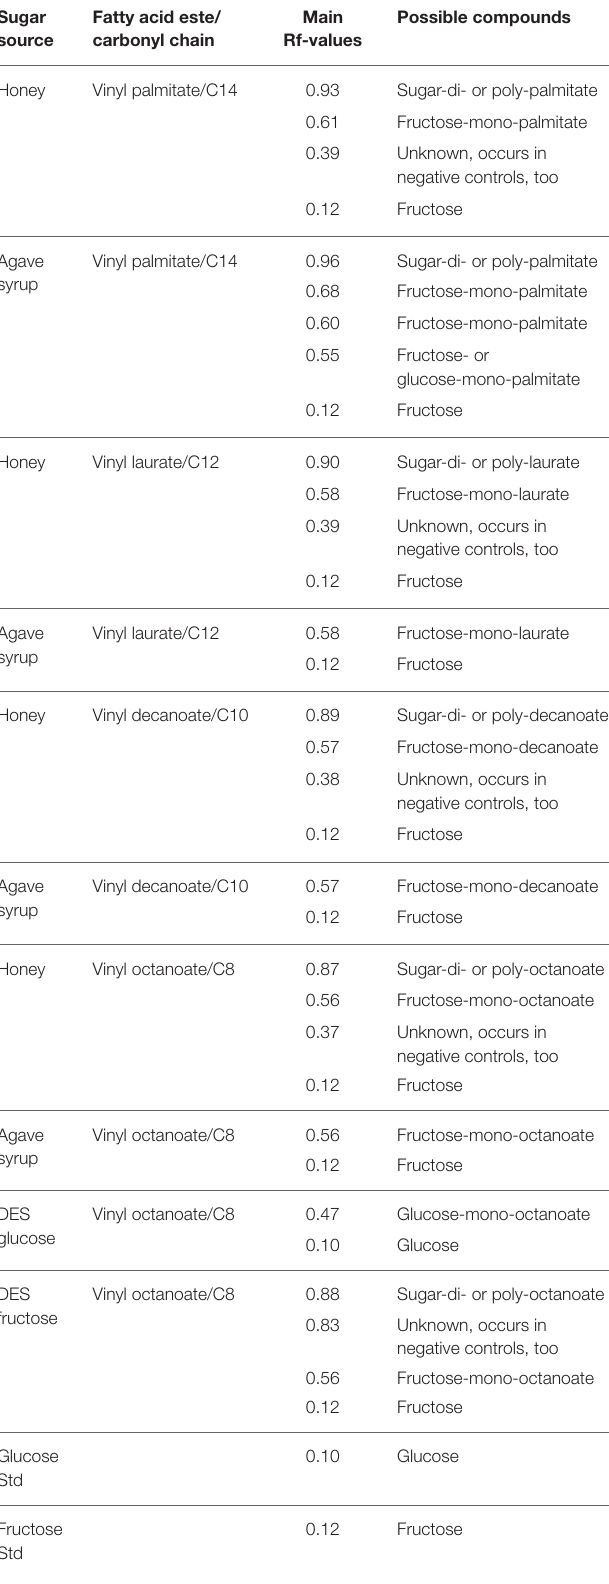
TABLE 3 | Observed m/z-values during ESI-Q-ToF experiments after flash purification of fraction 8 of with vinyl octanoate in honey, respective fraction 9 in agave